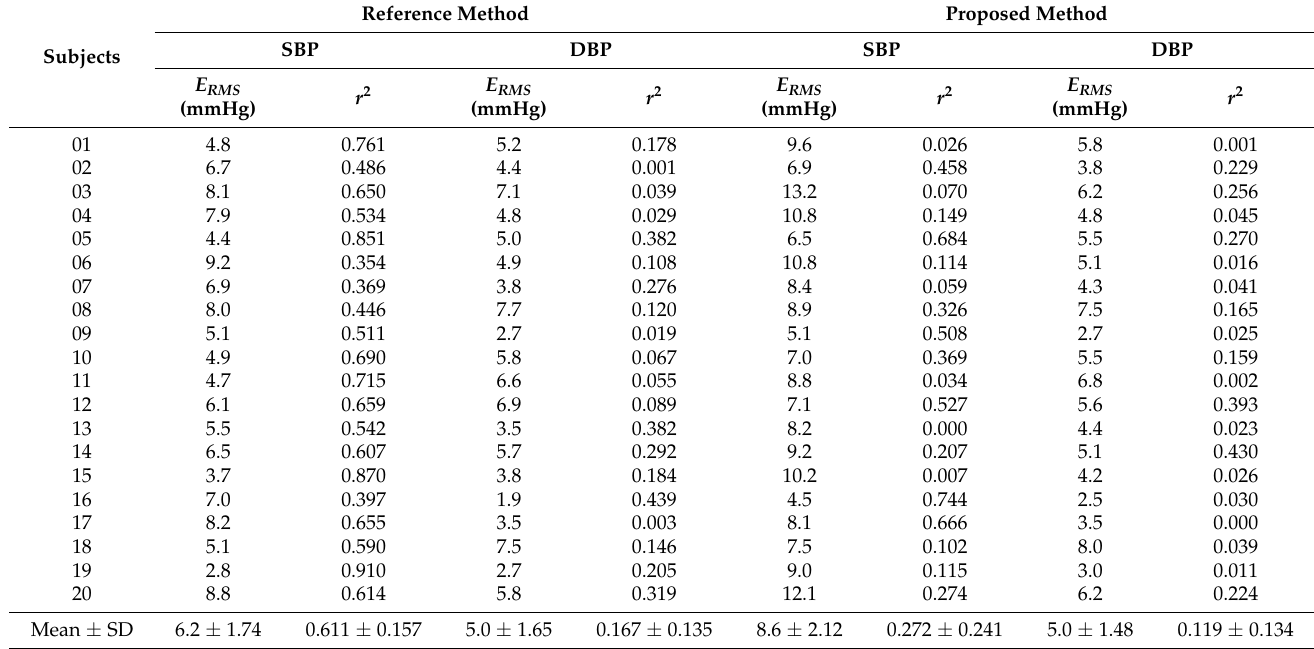
Table 3. The results of estimated systolic and diastolic blood pressures with Equation (2).